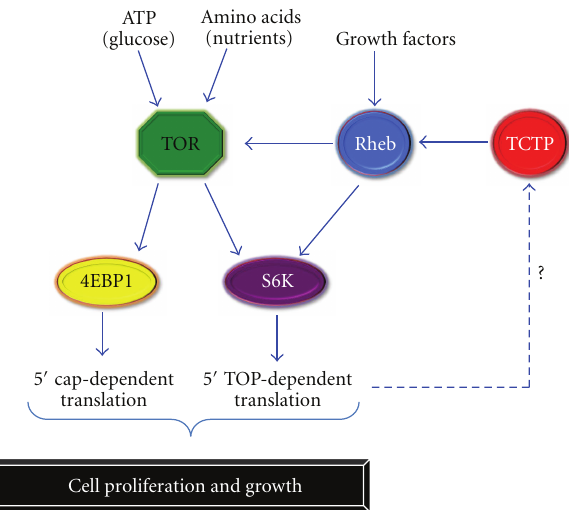
Figure 1: TCTP can activate the TOR pathway and promote cell proliferation and